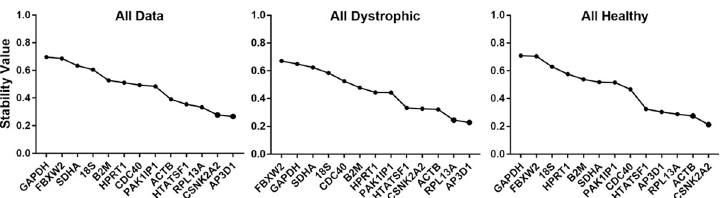
Fig 4. Normfinder analysis (ungrouped). Representative outputs of the Normfinder algorithm. Stability values (left to right: least stable to most stable) for the reference gene candidates are shown for the entire dataset or dystrophic or healthy samples alone (as